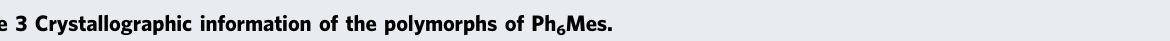
Table 3 Crystallographic information of the polymorphs of Ph 6 Mes. Crystallization